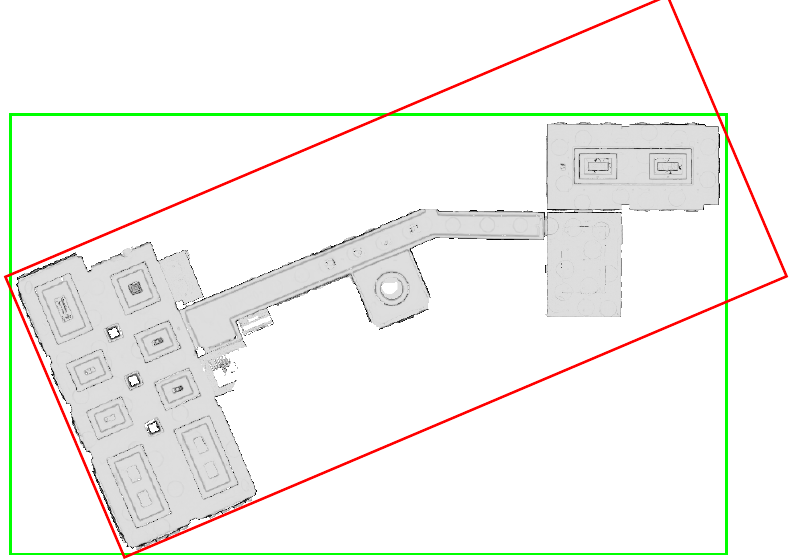
Figure 21. Resulting horizontal alignments of the triangle mesh “PuKPg4mmafe” from Figure 15h for the two peaks in the histogram of δ h values depicted in Figure 19. The green bounding box corresponds to the peak at δ v ≈ 0° (i.e., the ground truth pose), while the red bounding box corresponds to the peak at δ v ≈